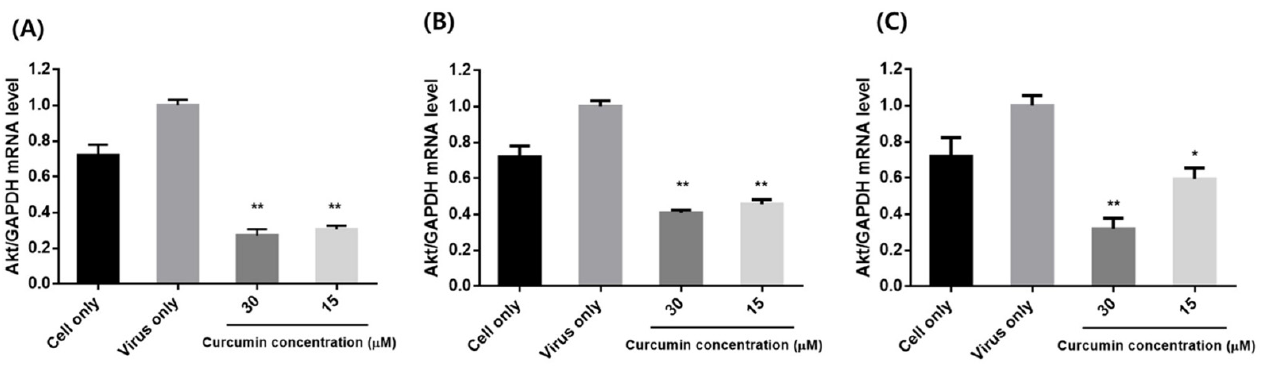
Figure 7. Effects of curcumin treatment on mRNA expression of Akt in influenza-infected MDCK cells: ( A ) pre-treatment: MDCK cells were pre-treated with different concentrations (15 and 30 µM) of curcumin and infected with influenza virus; ( B ) co-treatment: MDCK cells infected with virus were co-treated with different concentrations of curcumin; ( C ) post-treatment: MDCK cells were infected with virus and then incubated with curcumin. ** p < 0.001, * p < 0.05, compared with the virus group.